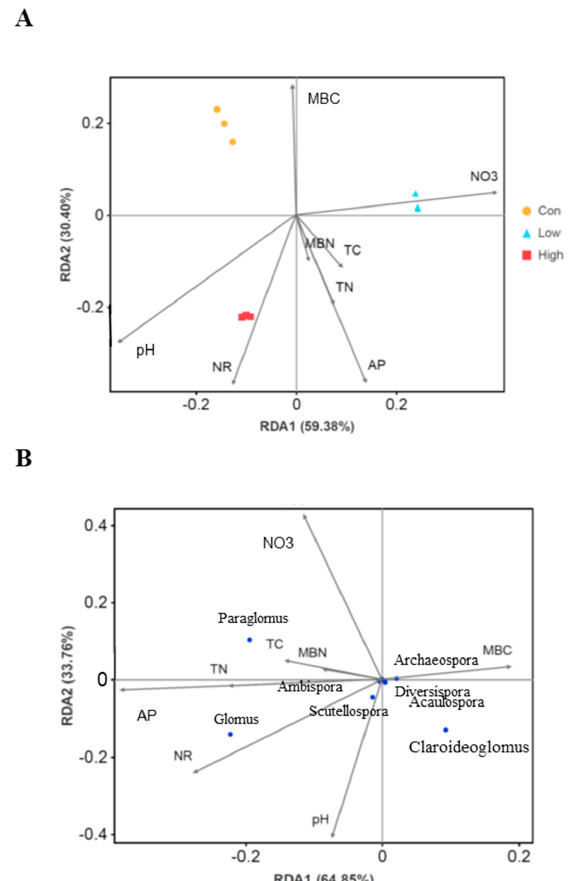
Figure 5. Redundancy analysis (RDA) between the AMF community composition in rhizospheric soil and environmental factors in poplar plantations treated with different concentrations of BS. ( A ) The RDA showed the relationship between the AMF community compositions based on the OTU abundance and environmental factors. ( B ) RDA for the correlations between AMF genera and envi-